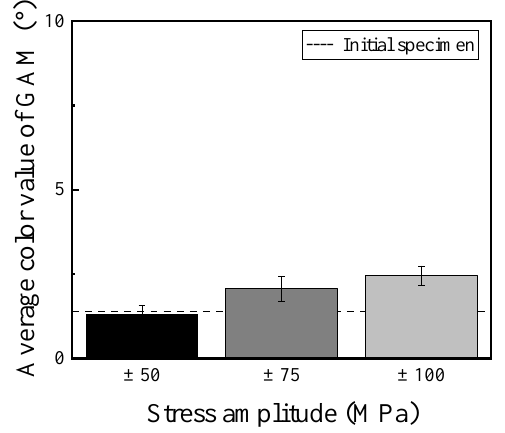
Figure 9. Grain average misorientation (GAM) maps of heat-treated C1020 specimens after low cycle fatigue test. ( a ) Stress amplitude: 50 MPa (fatigue cycle: 7,786,201 cycles); ( b ) stress amplitude: 75 MPa (fatigue cycle: 235,144 cycles); ( c ) stress amplitude: 100 MPa (fatigue cycle: 49,676 cycles).